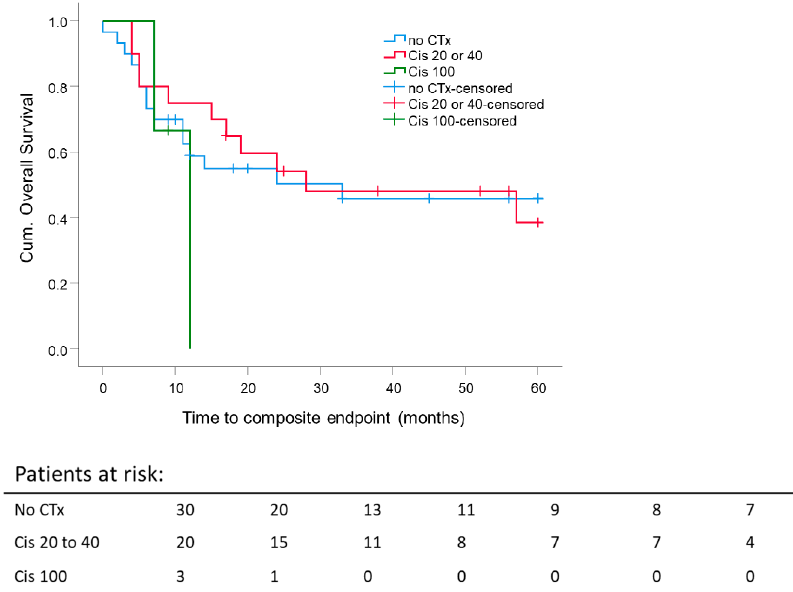
Figure 4. Impact of concurrent chemotherapy on 5 year composite overall survival: Kaplan–Meier curves were calculated from the date of diagnosis for 23 patients treated with concurrent chemotherapy. p = 0.62.